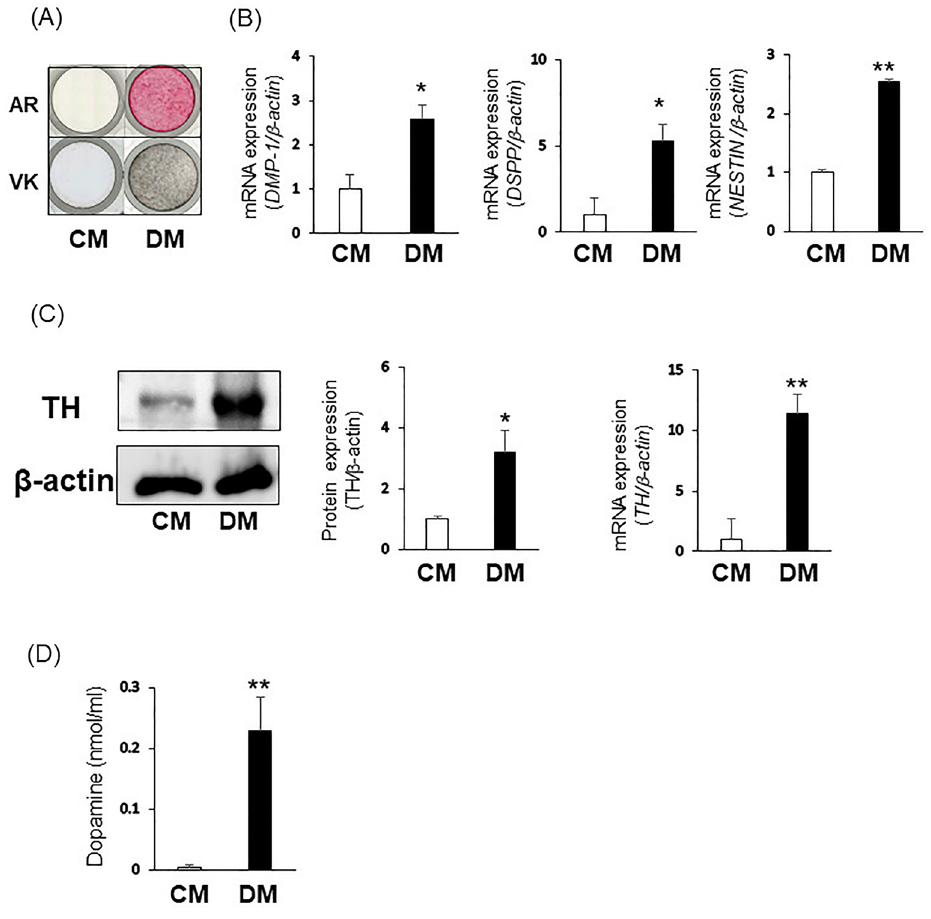
Figure 2. TH and DA expression during odontoblastic differentiation of DPSCs-3U. ( A – D ) 3U-DPSCs were cultured in CM or DM. ( A ) After 7 days of cultivation, calcium deposits were analyzed by Alizarin Red S staining and von Kossa staining. ( B ) After 3 days of cultivation, gene expression of DMP-1, DSPP, NESTIN was examined by quantitative RT-PCR. ( C ) Gene and protein expression of TH was investigated by quantitative RT-PCR and Western Blotting. The bands were quantified using ImageJ. Original blots are presented in Supplementary Information 8. ( D ) DA concentration of the culture supernatant of DPSCs was analyzed by ELISA. β-actin was used an internal control. Statistical analysis was performed using the Student’s unpaired t-test with Easy R software. n = 3, ** P < 0.01, * P <